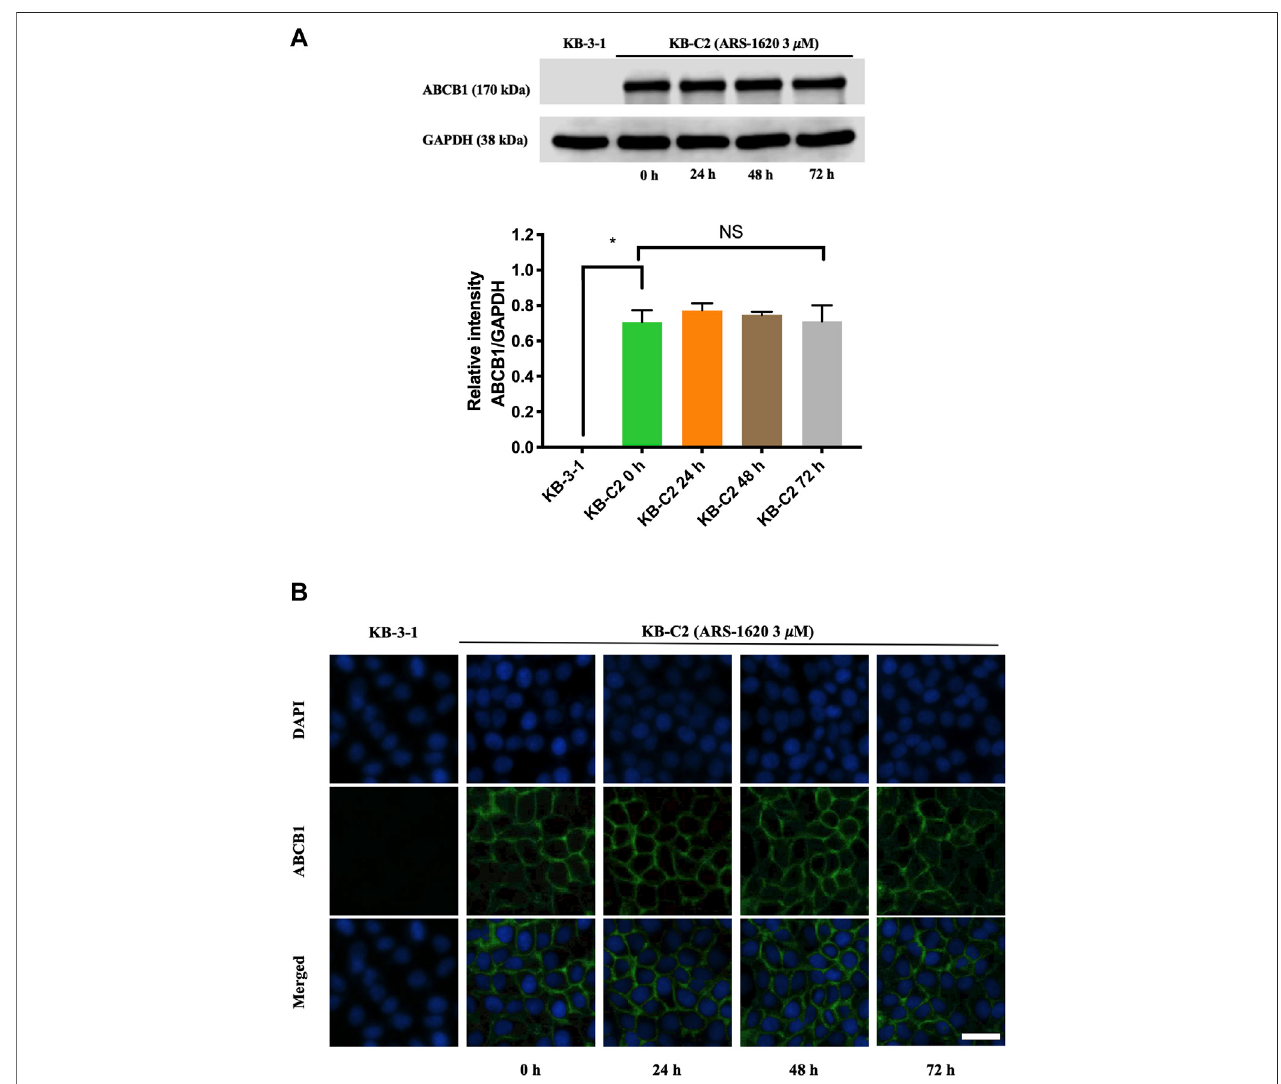
FIGURE 5 | ARS-1620 did not in fl uence the protein expression level and localization of ABCB1. (A) The ABCB1 expression level in KB-C2 cells with ARS-1620 (3 μ M) for 0, 24, 48, and 72 h. (B) The captured images displayed subcellular localization of ABCB1 transporter with ARS-1620 (3 μ M) for 0, 24, 48 and 72 h. Green showed ABCB1; blue showed DAPIcounterstains the nuclei; Scale bar: 200 μ m. Resultsare showed as mean ±SD ofthree independent experiments. NSindicates no signi fi cance.